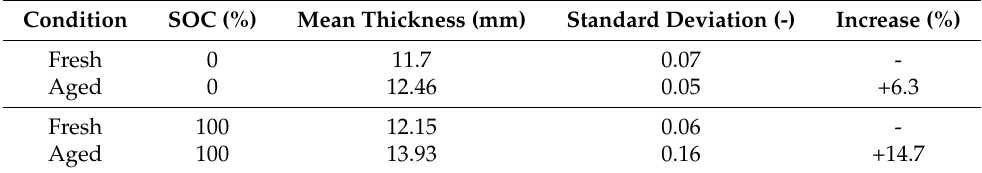
Table 3. Thickness comparison of fresh and aged cells dependent on the cell’s SOC measured with FaroArm® Platinum .